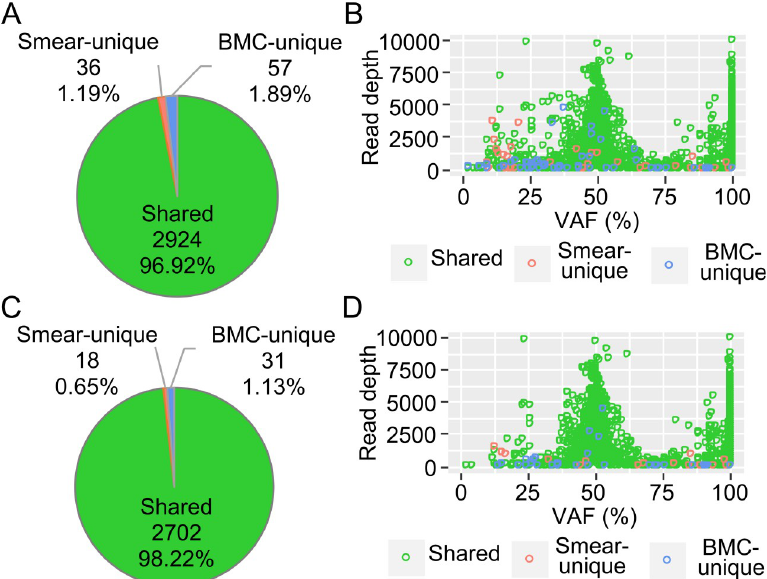
Fig 3. Characteristics of variants detected using HaplotypeCaller and the filtering effect. The combined results from five paired samples of smears and bone marrow cells (BMCs) are shown. (A) Pie chart of the smear-unique variants, BMC-unique variants, and shared variants. (B) Distribution of the detected variants. VAF, variant allele frequency. The smear-unique, BMC-unique, and shared variants are color-coded. (C) Pie chart of the variants after filtering. (D) Distribution of the filtered